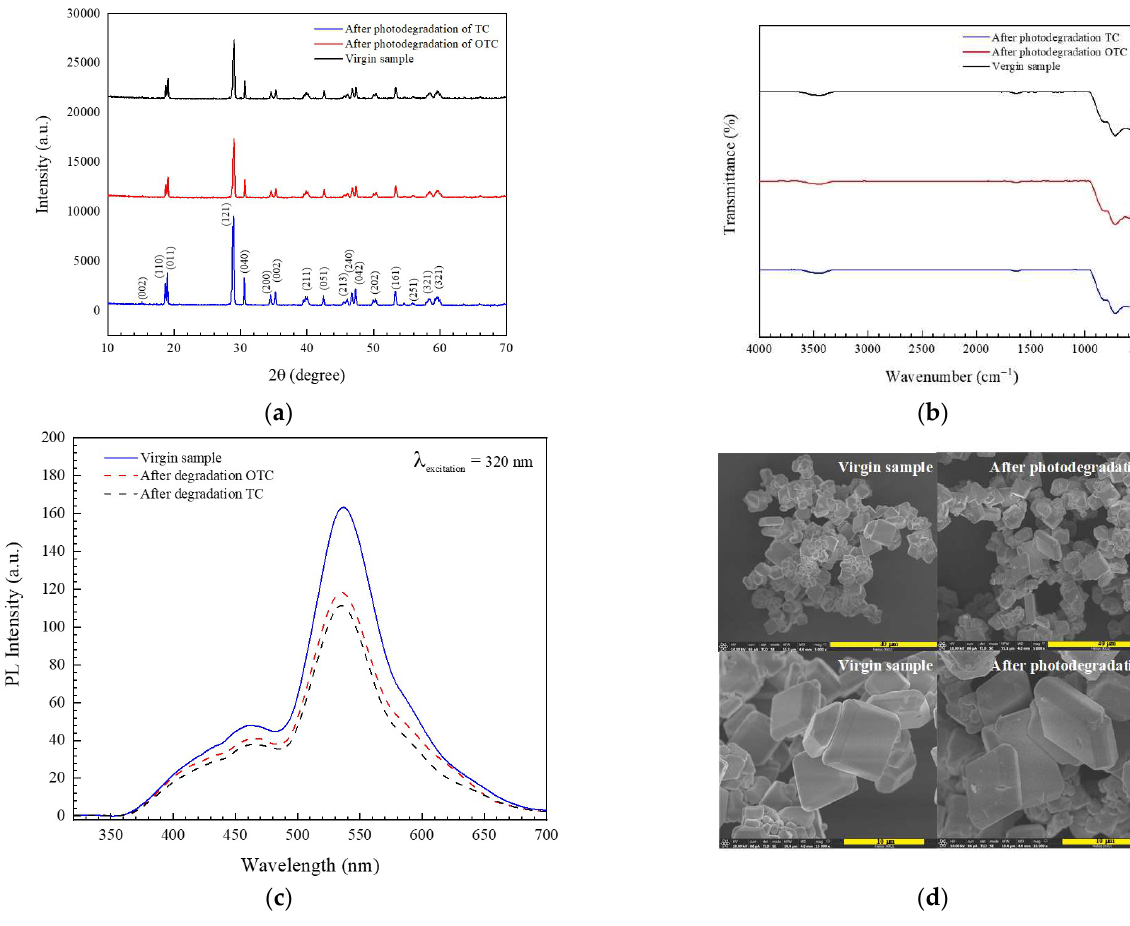
Figure 12. XRD patterns ( a ), FT-IR spectra ( b ), PL spectra ( c ), and SEM micrographs ( d ), of the BiVO 4 catalyst, before and after the degradation of the antibiotic.